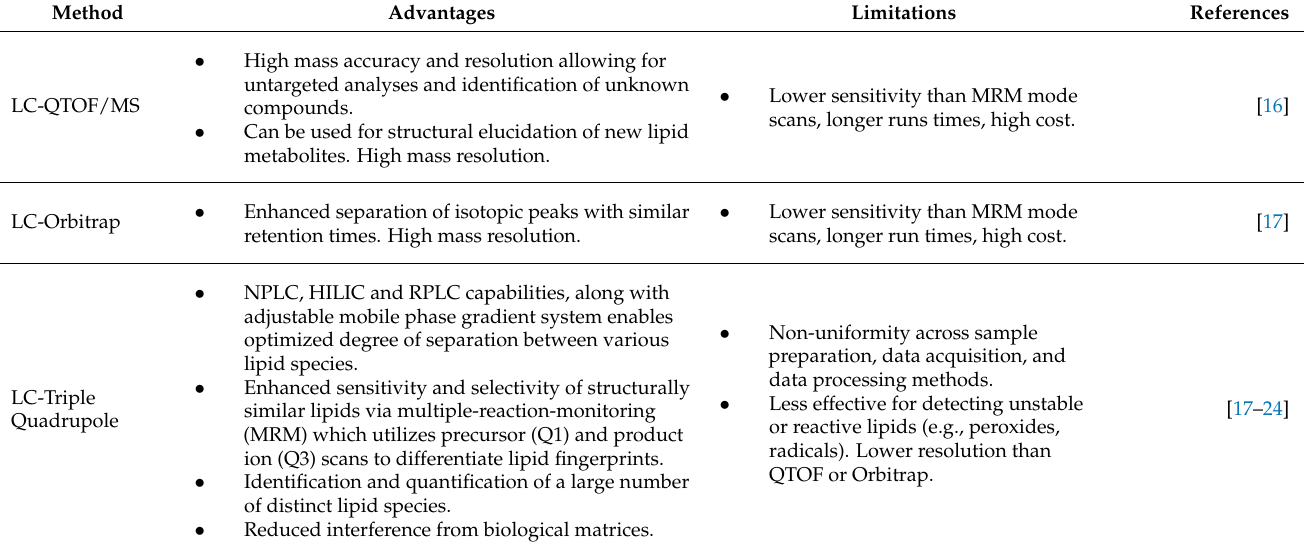
Table 1. Comparison of Mass Spectrometry